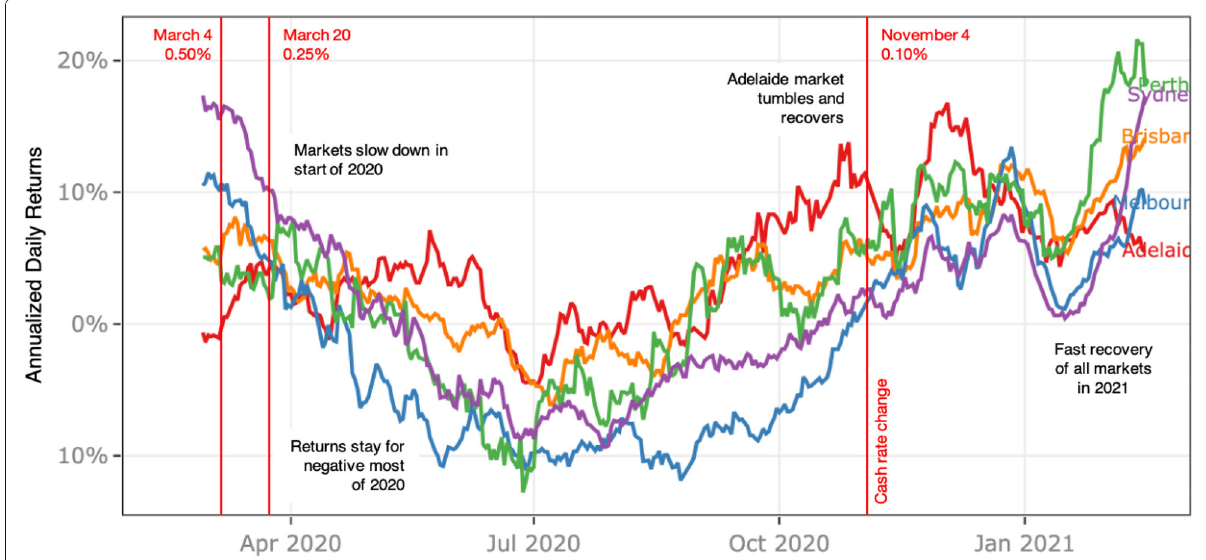
Fig.4 Daily momentum of the House Value Index from March 2020 until Feb 2021 measured as the annualised returns averaged over a 20 day